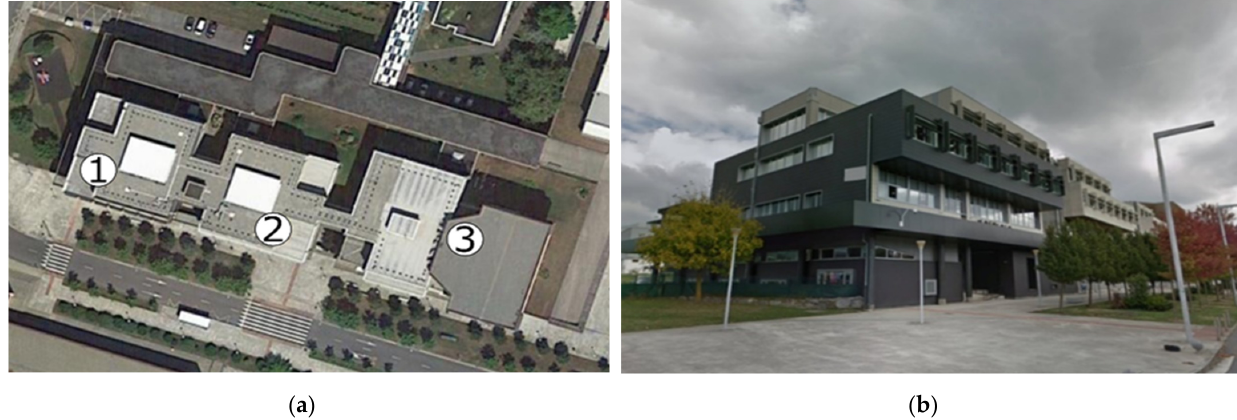
Figure 2. Rectorate building of the UPV/EHU located on Leioa, Vizcaya, in the north of Spain. ( a ) Plan view of the building of the blocks: 1-west block; 2-central block; 3-east block. ( b ) Façade view of the west block.